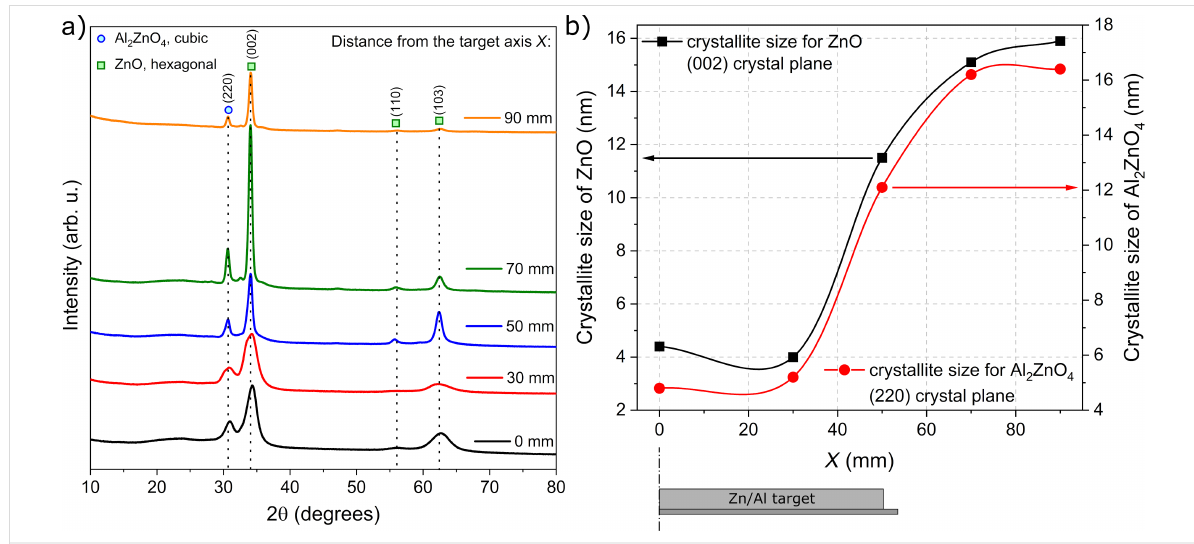
Figure 9: Results of the structural investigation: (a) XRD patterns and (b) crystallite sizes as functions of the distance X from the Zn/Al target axis. The lines in (b) are to guide the eye.